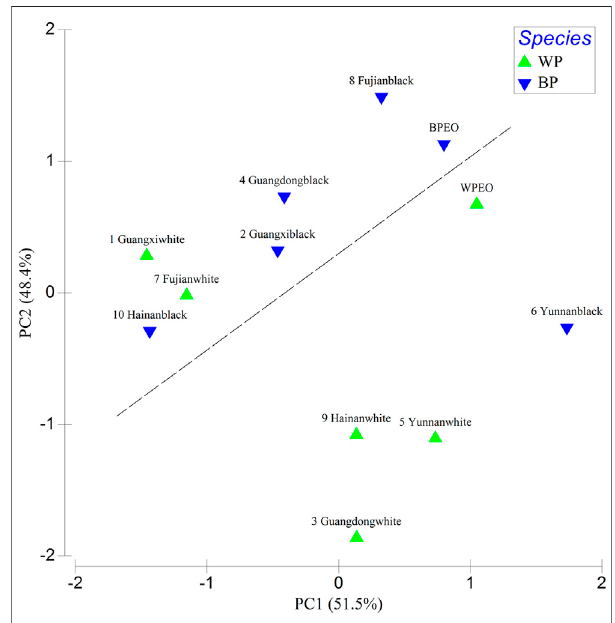
FIGURE 5 | PCA plot based on the DPPH radical scavenging activities (DR) and superoxide radical scavenging activities (SR) of the essential oils from white pepper and black in the present study and fi ve different habitats reported by Li et al. ( : White pepper; : Black pepper; WPEO and BPEO in this study; 1 (Guangxi white), 2 (Guangxi black), 3 (Guangdong white), 4 (Guangdong black), 5 (Yunnan white), 6 (Yunnan black), 7 (Fujian white), 8 (Fujian black), 9 (Hainan white), and 10 (Hainan black) in Li et al. ’ s study [18] ; WPEO, white pepper essential oil; BPEO, black pepper essential